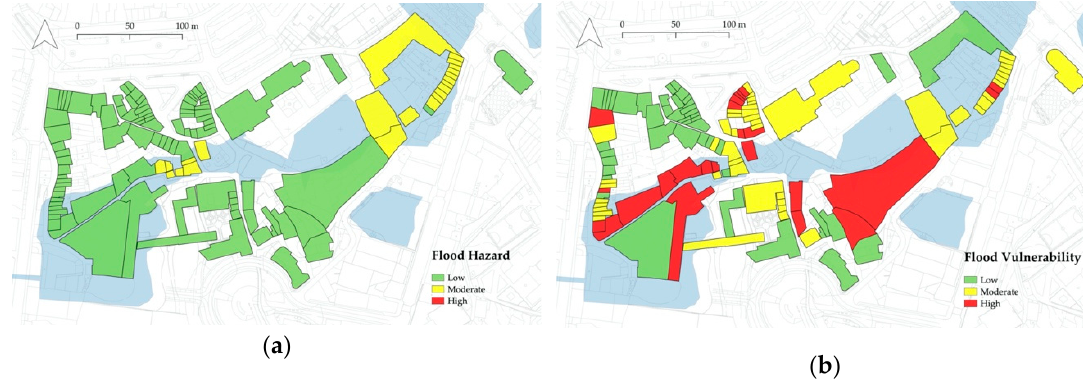
Figure 12. Spatial distribution of the flood hazard ( a ) and flood vulnerability results ( b ).